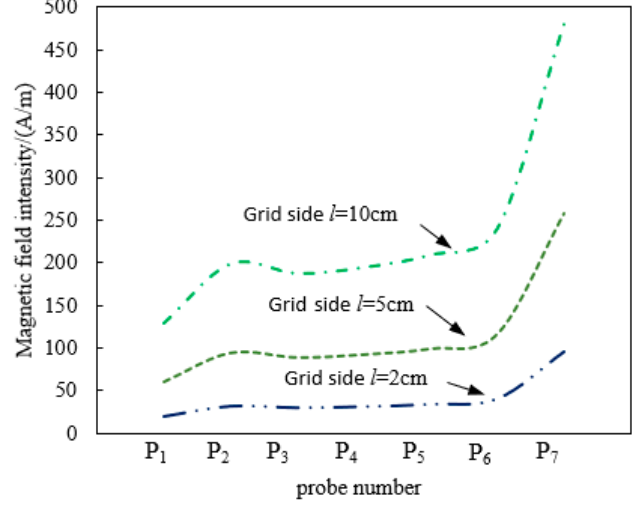
Figure 6. Magnetic field intensity values with di ff erent probes inside the nacelle.